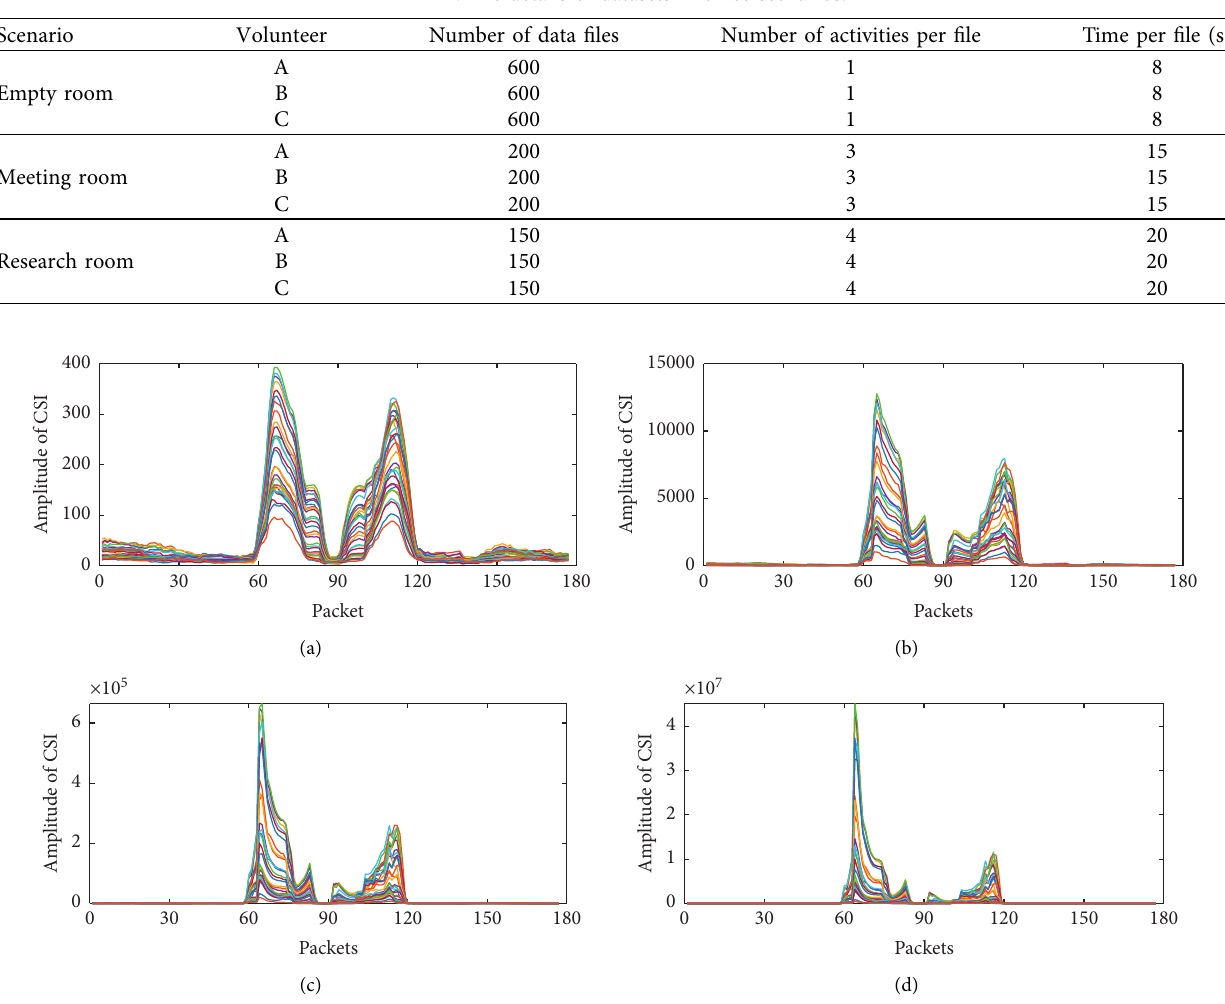
Figure 12: The impact of different p values on signal enhancement. (a) p � 1, (b) p � 2, (c) p � 3, and (d) p � 4.